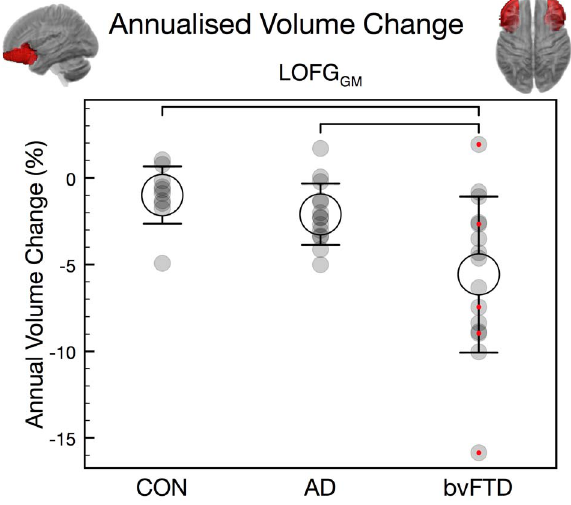
Figure 2. Annualised volume change (%; mean + / – 1 S.D.) of LOFG grey matter. Brackets indicate significant group differences. Red dots indicate data from Freiburg. CON = control participants.